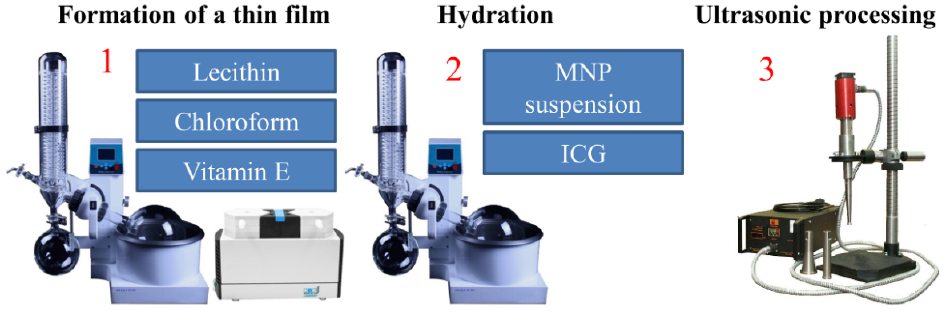
Figure 1. Scheme of the synthesis of aqueous